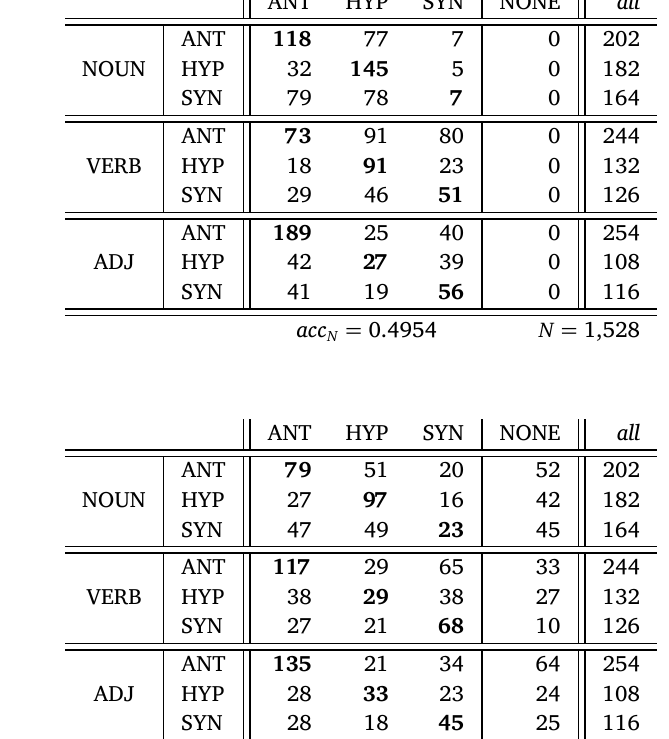
Confusion matrix for class assignment using lmi-based WINDOW-DIFF features